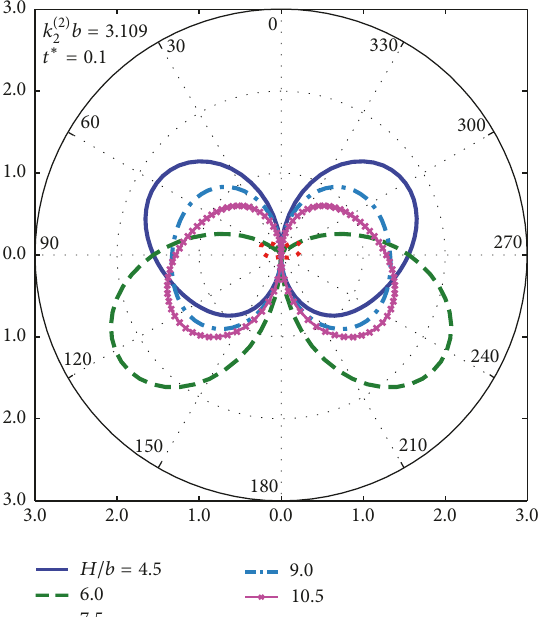
Figure 13: Tangential displacement (𝑢 ∗ 𝜃 ) versus polar angle at 𝑟 = 𝑏 for different depths (𝐻/𝑏) for a tunnel in soft